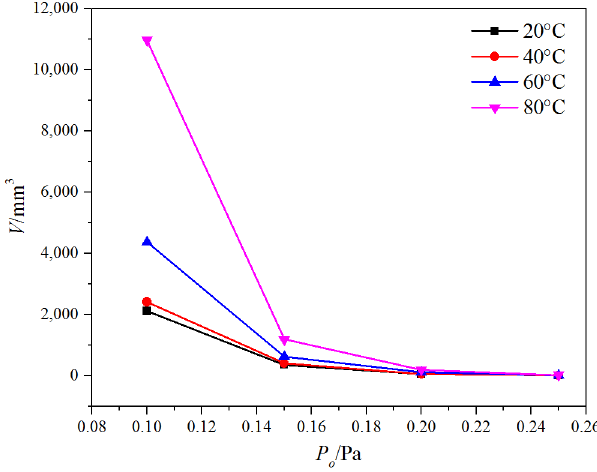
Figure 10. Water vapor volume in the two-cage globe valve with different outlet pressure and working temperature.